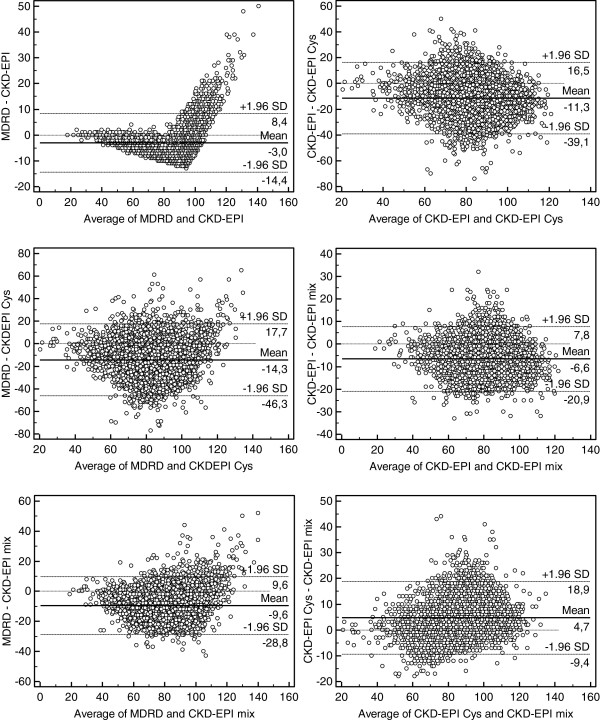
Bland and Altman analysis between the MDRD study, the CKD-EPI, the CKD-EPI Cys and the CKD-EPI mix equations. The continuous line represents the mean difference between measured and estimated GFR, whereas the dashed lines represent the limits of agreement (mean difference ± 2 SD). All values are expressed in mL/min/1.73 m2.